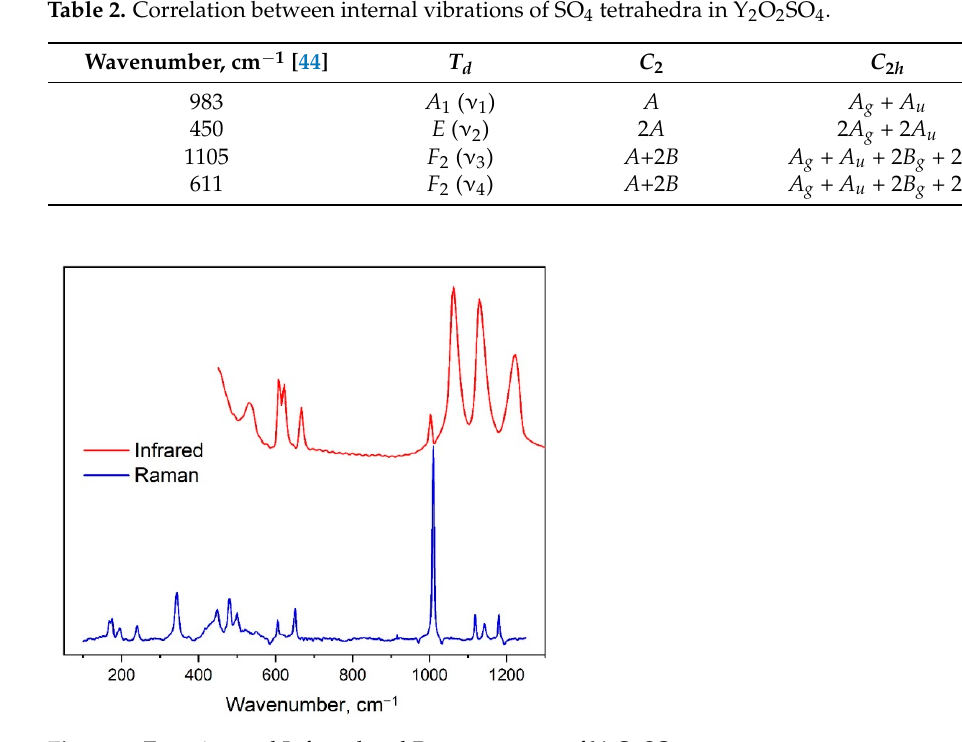
Figure 6. Experimental Infrared and Raman spectra of Y 2 O 2 SO 4 . Table 3. Calculated and experimental phonon wavenumbers (cm − 1 ) of Y 2 O 2 SO 4 with proposed assignments. Notations: Irreps.—irreducible representations, str.—stretching, tr.—translation, rot.—rotation, def.—deformation.